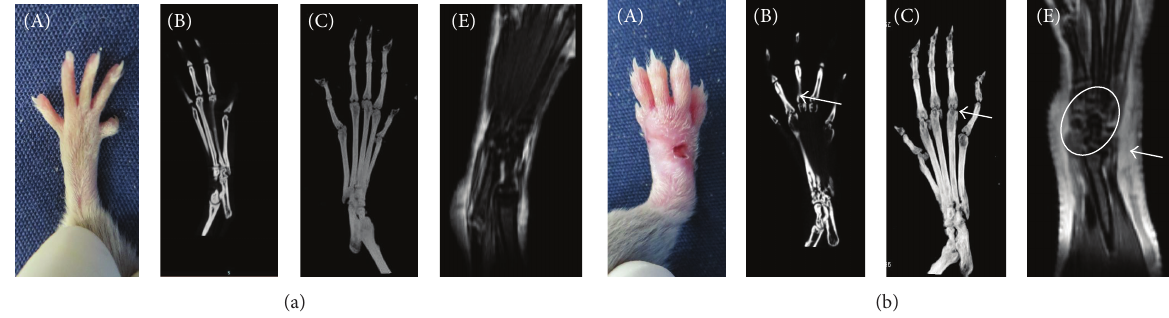
Figure 2: The imaging evaluations. (a) Images of the Normal mice. (A) Clinical imaging; (B) Micro-CT coronal imaging; (C) three- dimensional imaging; (E) MRI imaging. (b) Images of the CIA mice. (A) The clinical imaging showed four toes, palm and ankle swelling, and palm skin ulceration; (B) CIA mouse Micro-CT coronal imaging revealed cystic destruction at metacarpophalangeal joints; (C) three- dimensional Micro-CT imaging revealed bone thinning at the metacarpophalangeal and proximal interphalangeal joints; (E) there was significant signal enhancements at a large area of soft tissues surrounding the joints, as indicated by the arrows. In addition, there was visible signal enhancement at articular surface of the annular region, suggestive of synovitis and bone marrow